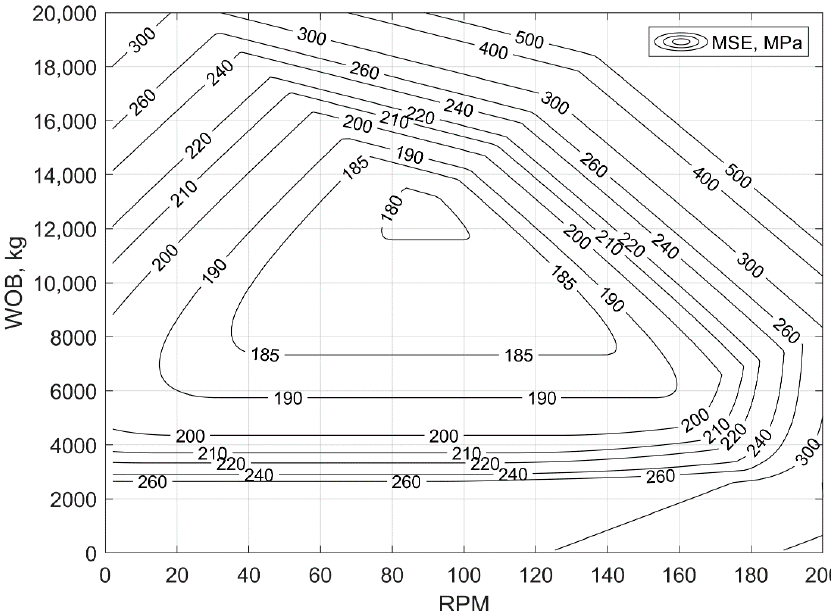
Figure 6. Contour plot of MSE as a function of WOB and RPM in formation A .